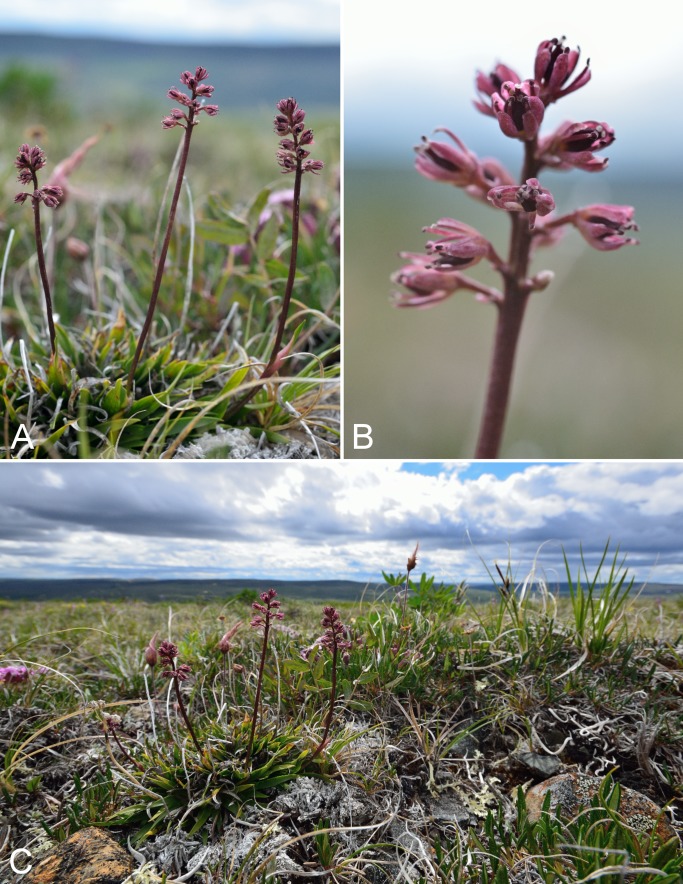
Tofieldia coccinea.(A) Habit, Saarela et al. 3770. (B) Inflorescence, Saarela et al. 3770. (C) Habitat, Saarela et al. 3770. Photographs by R. D. Bull.